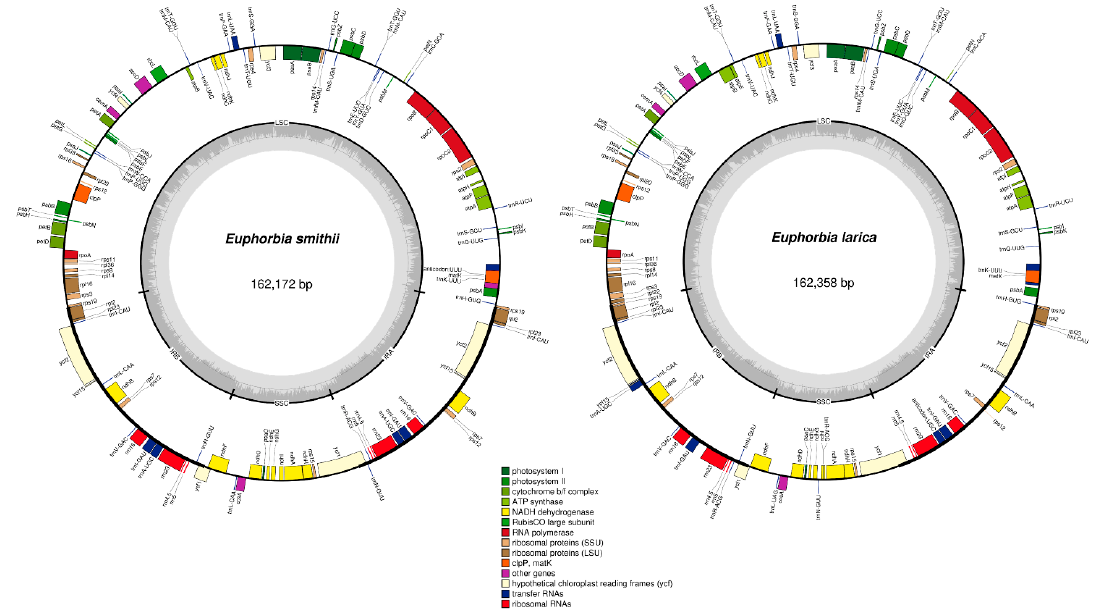
Figure 1. Genome circular map of the E. smithii and E. larica . Thick lines indicate the extent of the inverted repeat regions (IRa and IRb), which separate the genome into small (SSC) and large (LSC) single copy regions. Genes drawn inside the circle are transcribed clockwise, while those outside of the circle are transcribed counter-clockwise. Genes belonging to di ff erent functional groups are color-coded. The dark gray in the inner circle corresponds to the GC content, while the light gray corresponds to the AT content.